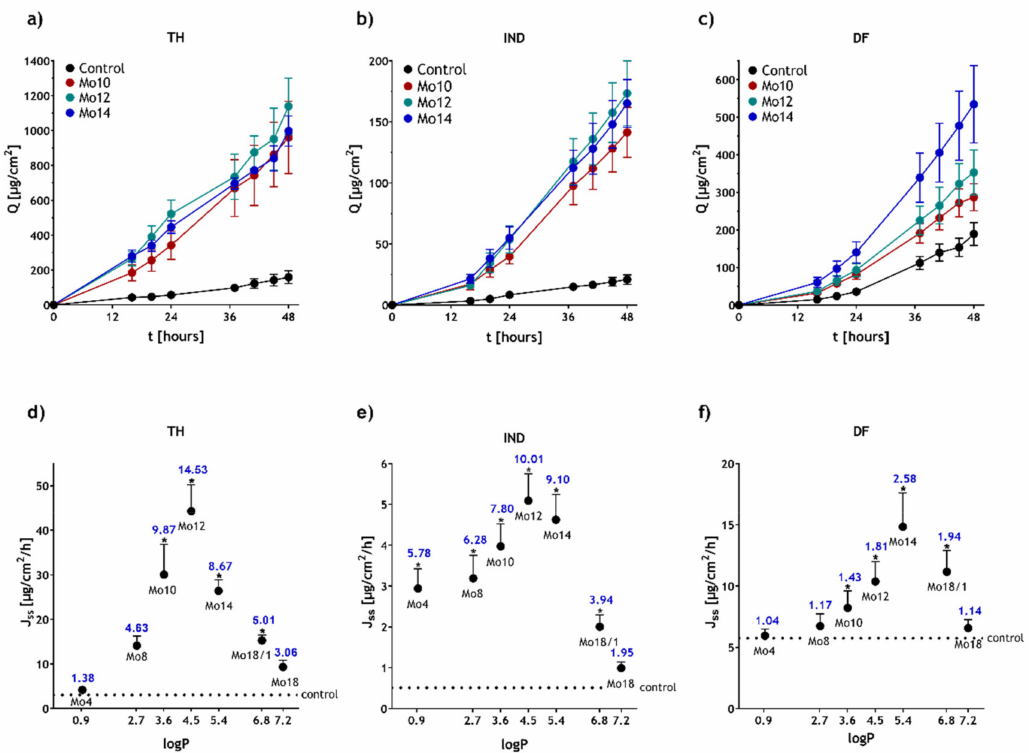
Figure 1. Effects of the studied enhancers (1%) on skin permeability. Permeation profiles of TH ( a ), IND ( b ) and DF ( c ) for the most active enhancers. Flux of TH ( d ), IND ( e ) and DF ( f ) vs. LogP of the studied enhancers. The black dotted line represents the flux of model drugs from a pure vehicle (with no enhancer). The blue numbers represent enhancing ratios. Data are presented as means ± SEM, n ≥ 16; * Statistically significant differences compared to the negative control (pure vehicle) at p <